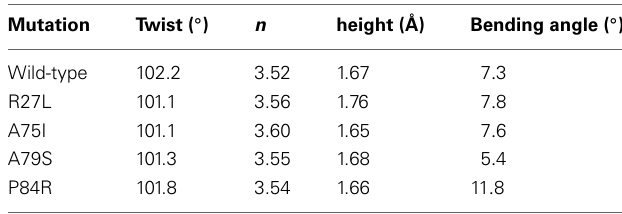
Table 3 | Changes in helix properties in helix α -4 of glutaredoxin (Bansal et al., 2000; Kumar and Bansal,